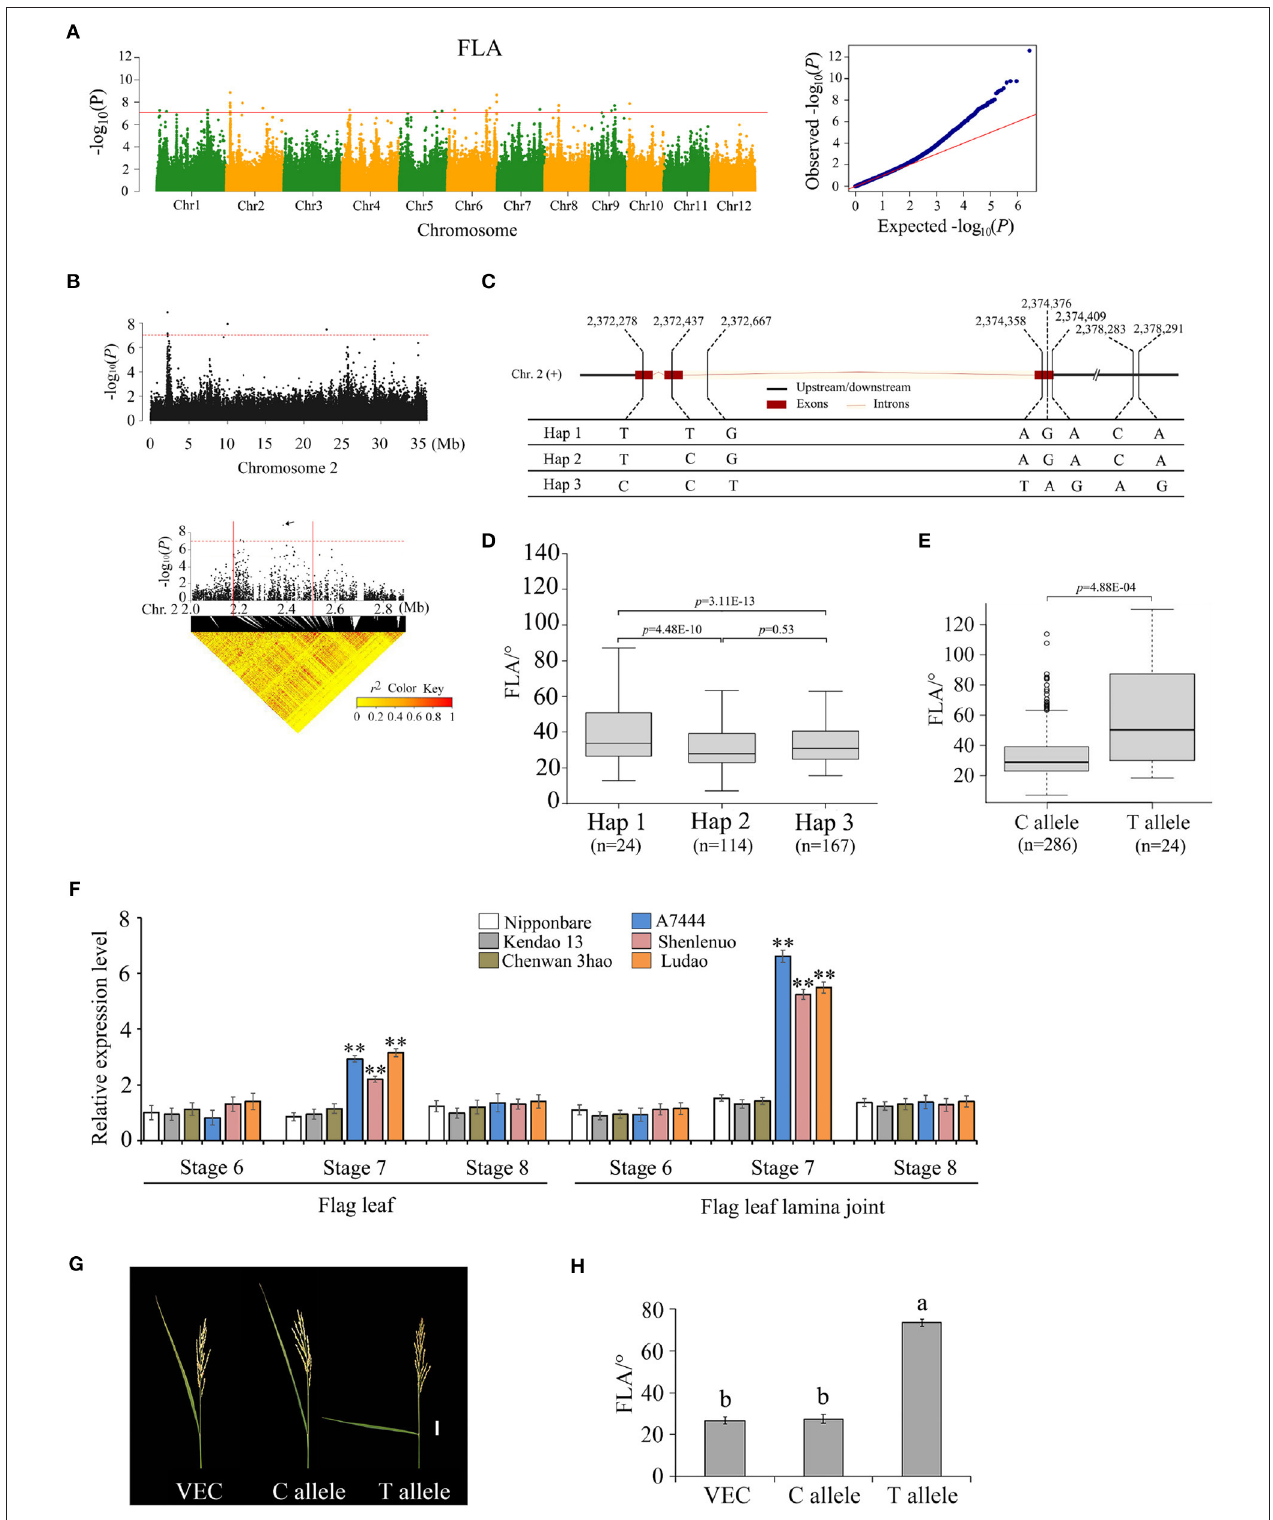
FIGURE 4 | Genome-wide association study for FLA and identification of the causal gene OsFLA2 ( Os02g0142875 ). (A) Manhattan plots for FLA. Red line indicates the significance threshold (–log 10 P = 7.0). (B) Local Manhattan plot (top) and LD heatmap (bottom) on chromosome 2. The arrow indicates the position of